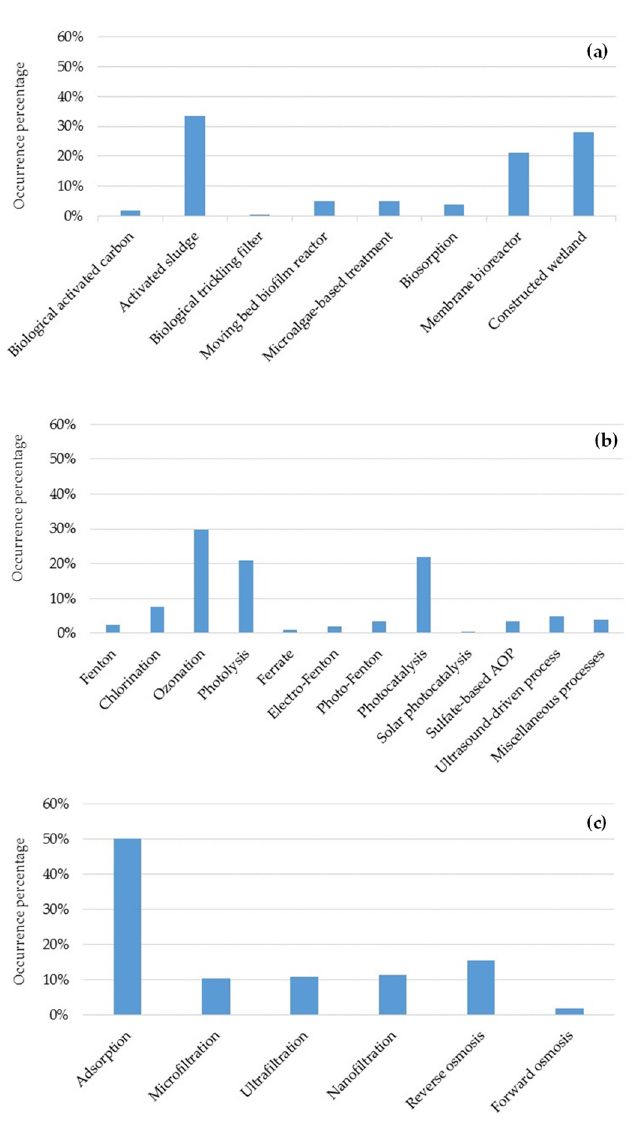
Figure 8. Treatment technologies in biological ( a ), chemical ( b ) and physical ( c ) processes. It is important to highlight the process of activated sludge (33.58%), followed by constructed wetland (28.05%) and membrane bioreactor (21.08%).